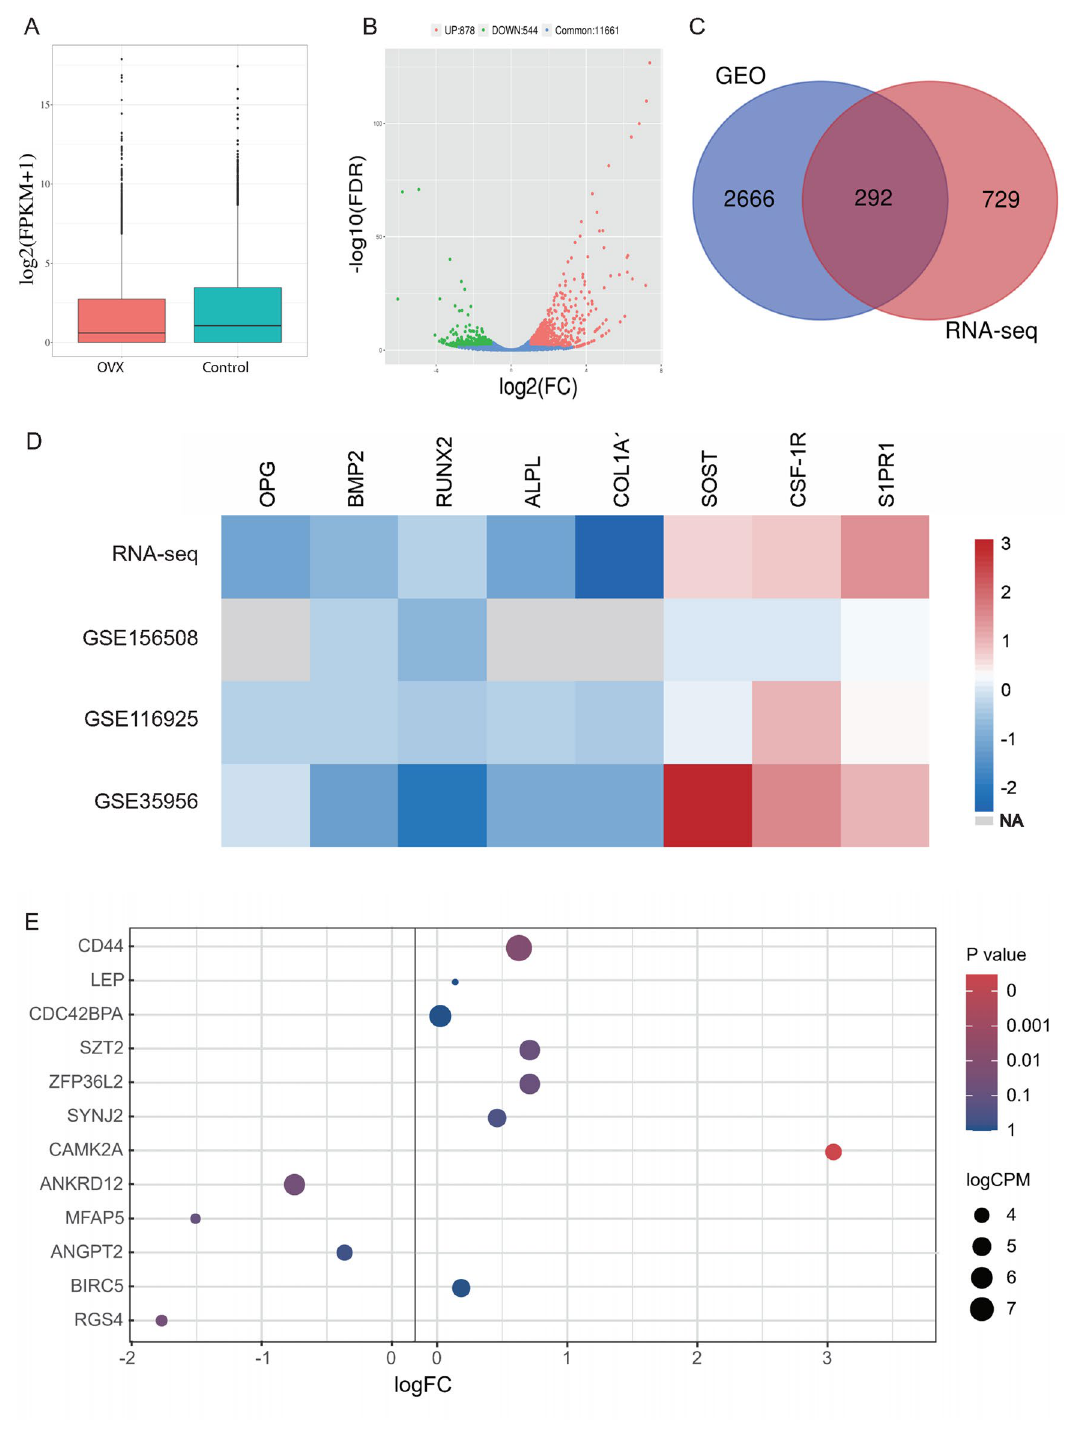
Figure 7. RNA-seq verification of target genes. ( A ) Comparison of the FPKM distribution of all samples. ( B ) Volcano Plot of gene expression differences. ( C ) RNA-seq data and GEO data were compared by a Venn diagram. ( D ) Comparisons of OP relative genes in GEO databases and RNA-seq data. ( E ) Bubble chart of verification of target genes by RNA-seq